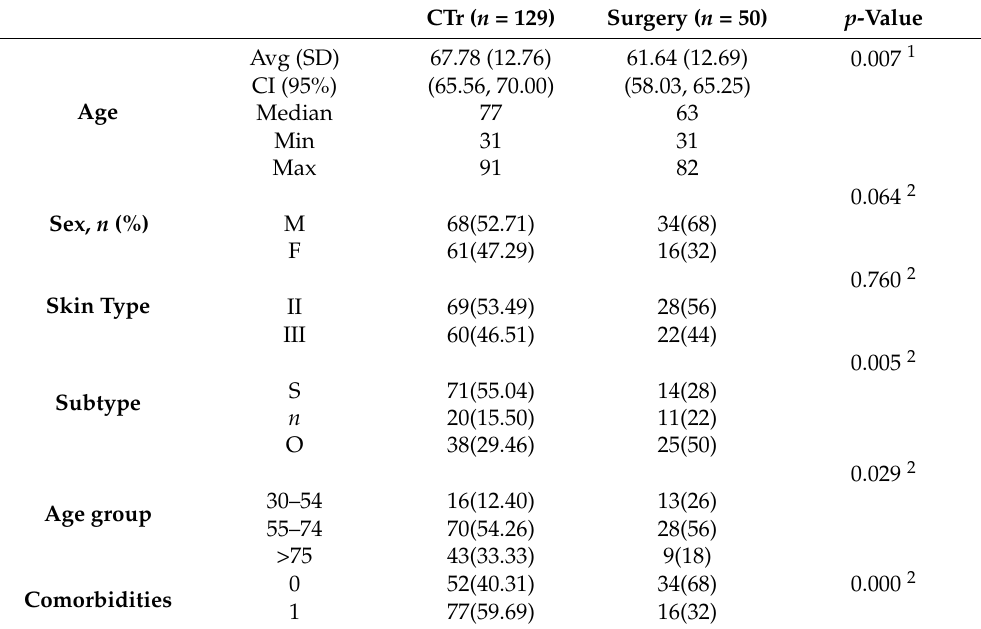
Table 1. Demographic, clinical, and histopathological data.